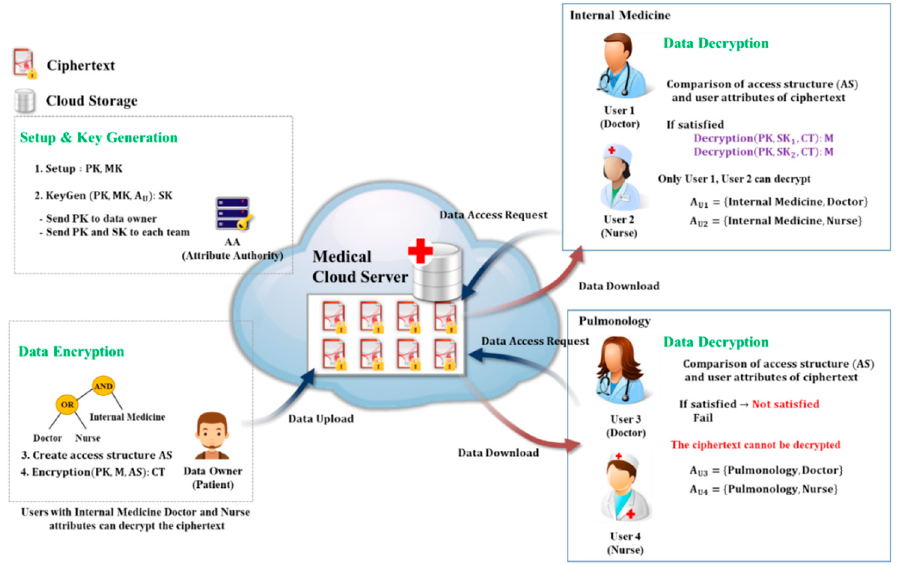
Figure 3. Medical data sharing system based on CP-ABE in a cloud Internet of Medical Things (IoMT) environment. Sensors 2020 , 20 , x FOR PEER REVIEW